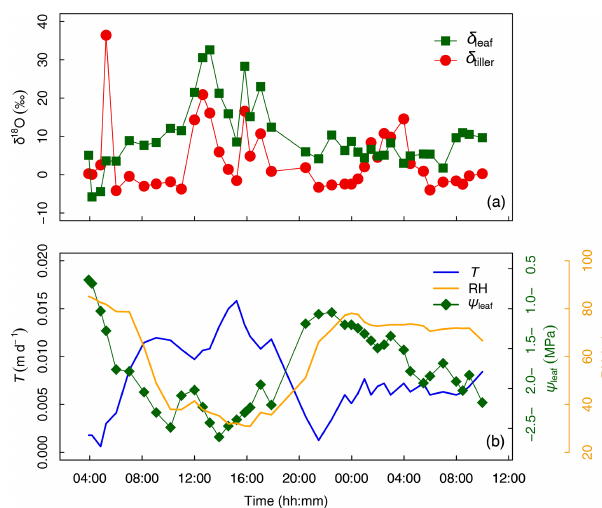
Figure 3. (a) Time series of tiller and leaf water oxygen isotopic compositions ( δ tiller and δ leaf , respectively, ‰). (b) Transpiration flux ( T , in md − 1 ), relative humidity (HR, %), and leaf water poten- tial ( ψ leaf , in MPa) from days after seeding (DaS) 167 at 04:00LT to DaS 168 at 11:00LT. Labeling was carried out on DaS 166 at